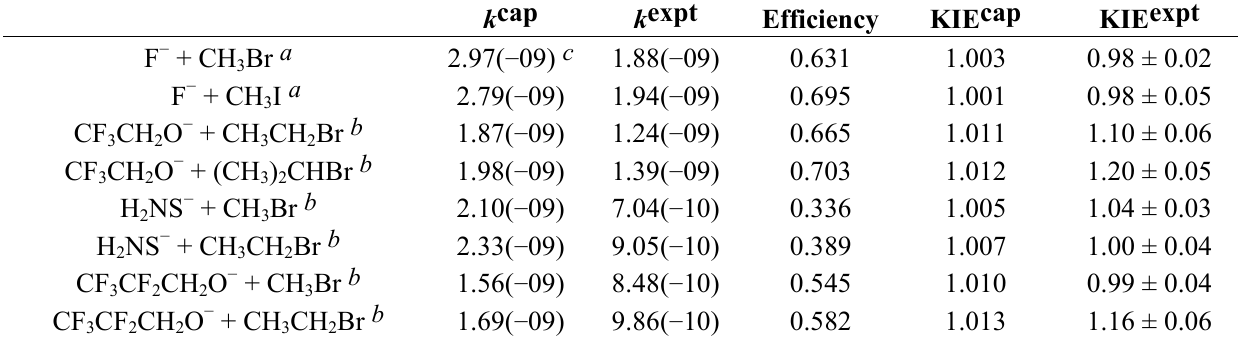
a Experimental values from ref. [20] at 302 K; b Experimental values from reference [8], calculations done at